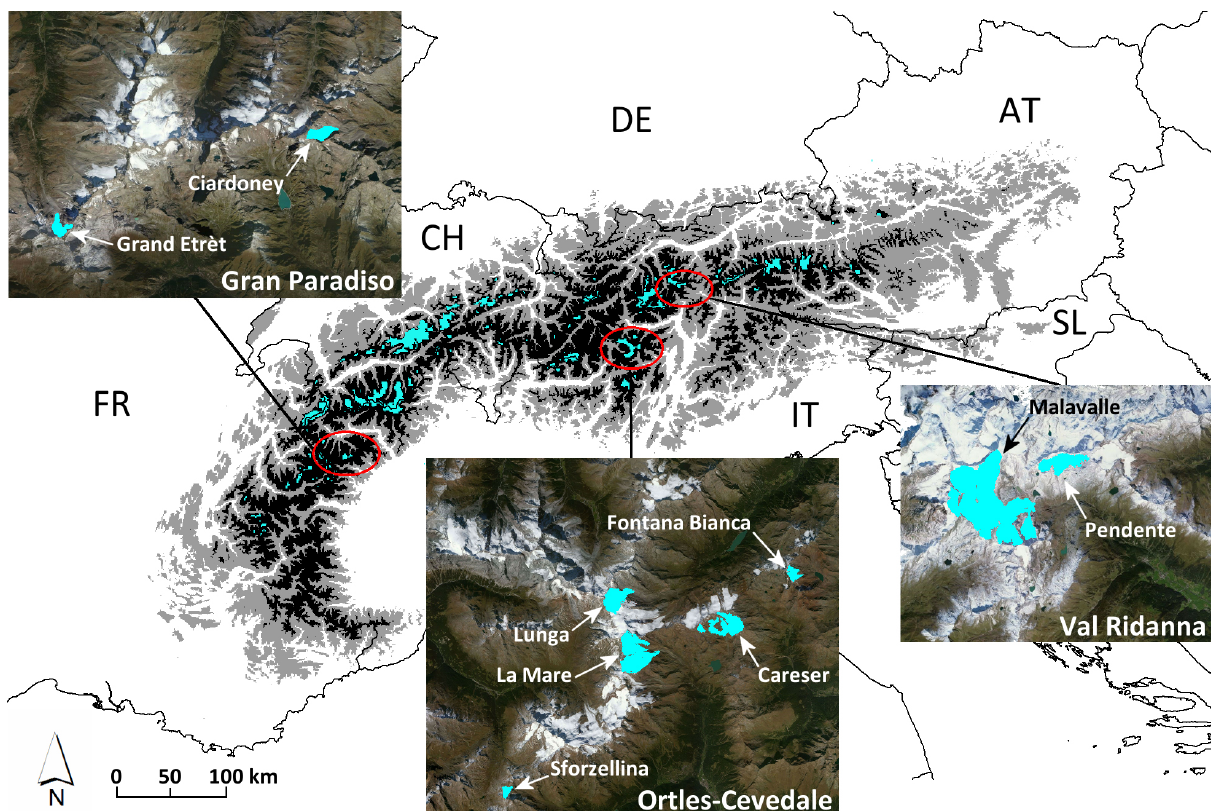
Figure 1. Geographic setting of the glaciers with mass balance measurements analyzed in this work (Microsoft ® Bing ™ Maps).